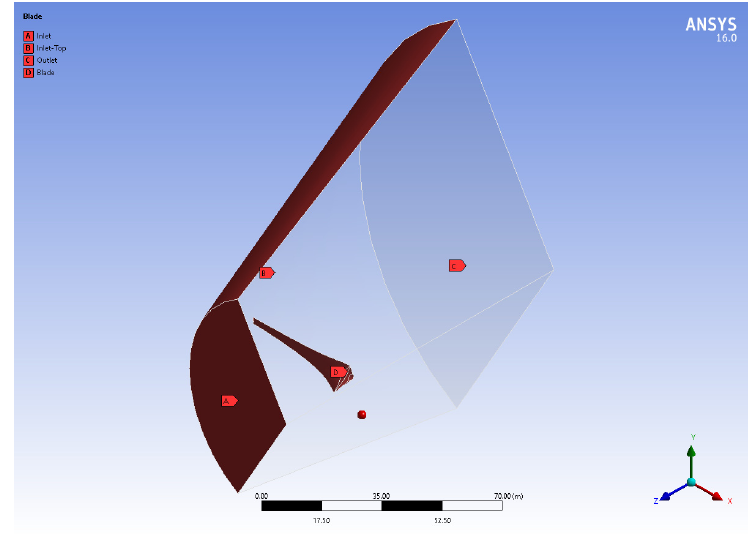
Figure 4. Computational domain and boundary conditions.